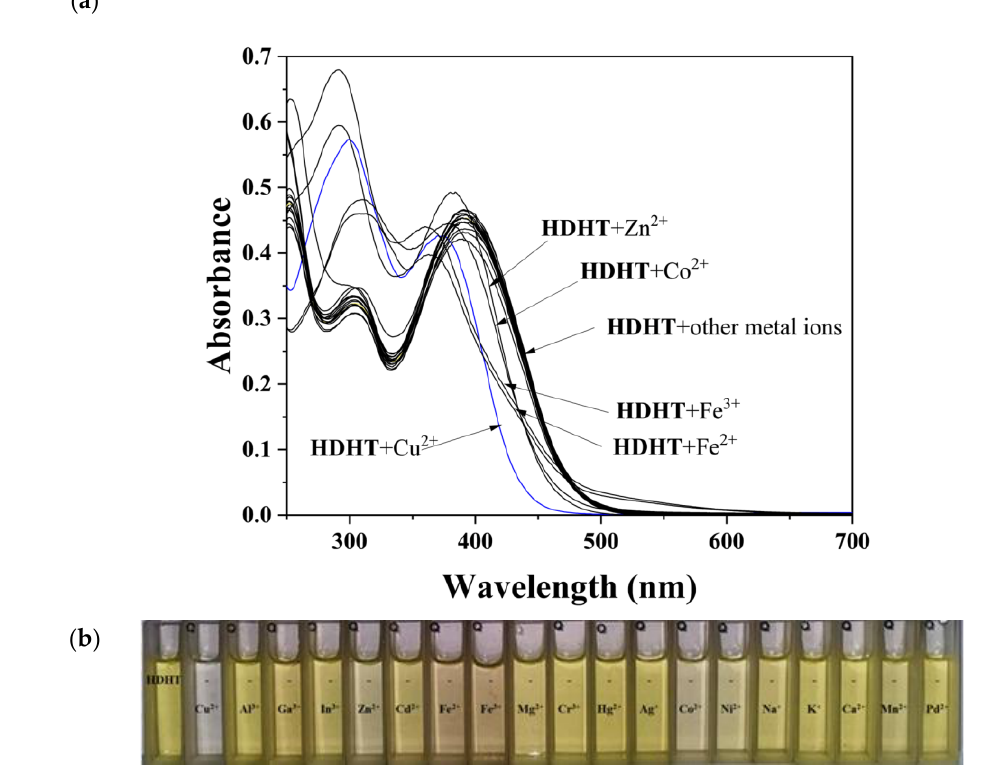
Figure 1. ( a ) Absorbance spectra of HDHT (30 μM) with metal ions (39 μM). ( b ) Photograph of color changes of HDHT (30 μM) with metal ions (39 μM).